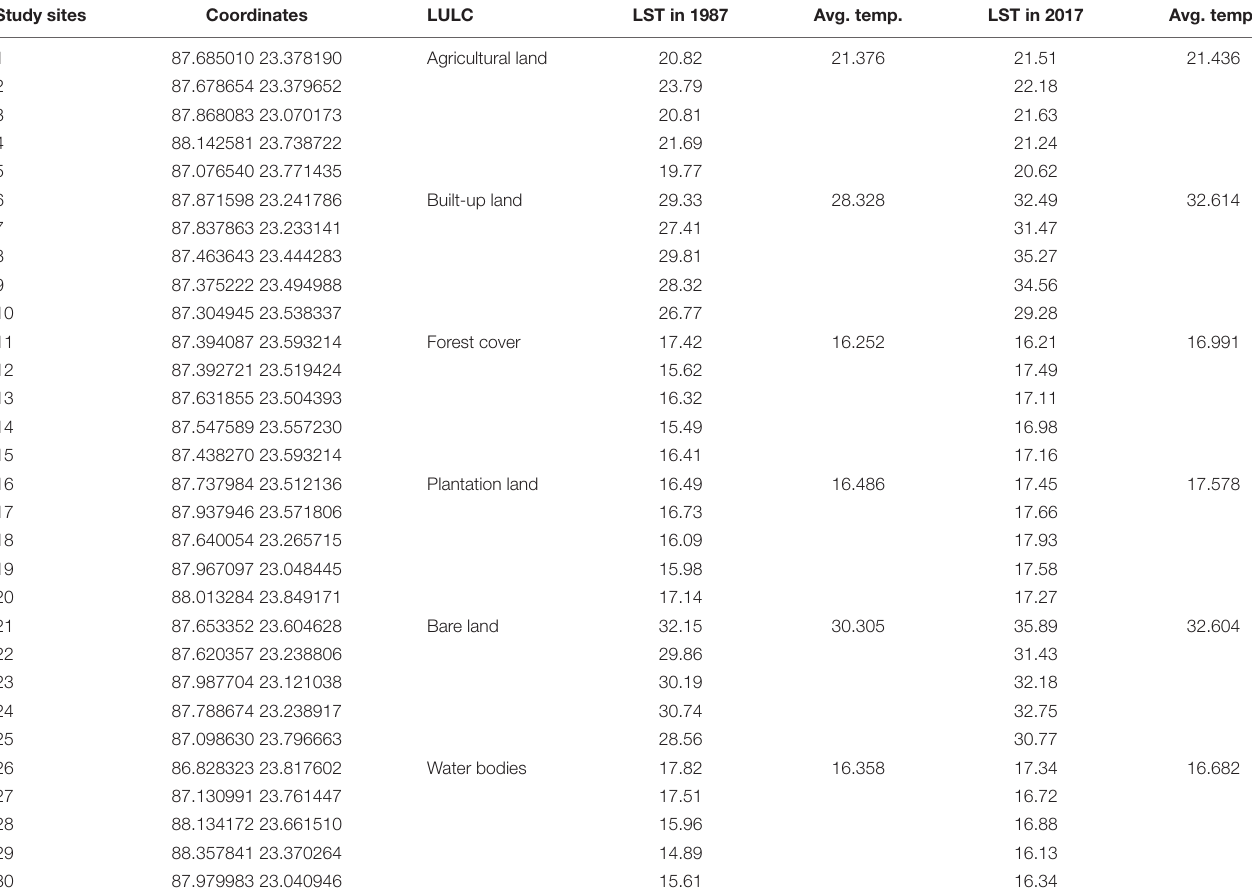
TABLE 3 | LST ( ◦ C) of Barddhaman district, 1987 and 2017. Study sites